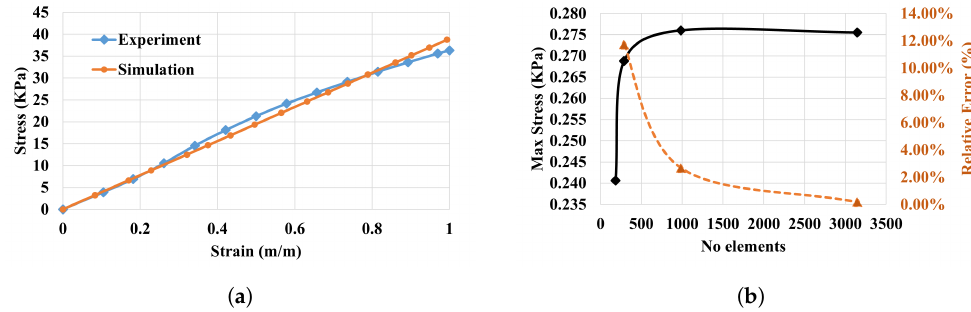
Figure 8. ( a ) Stress–strain diagram of Ecoflex™00-30; ( b ) mesh sensitivity